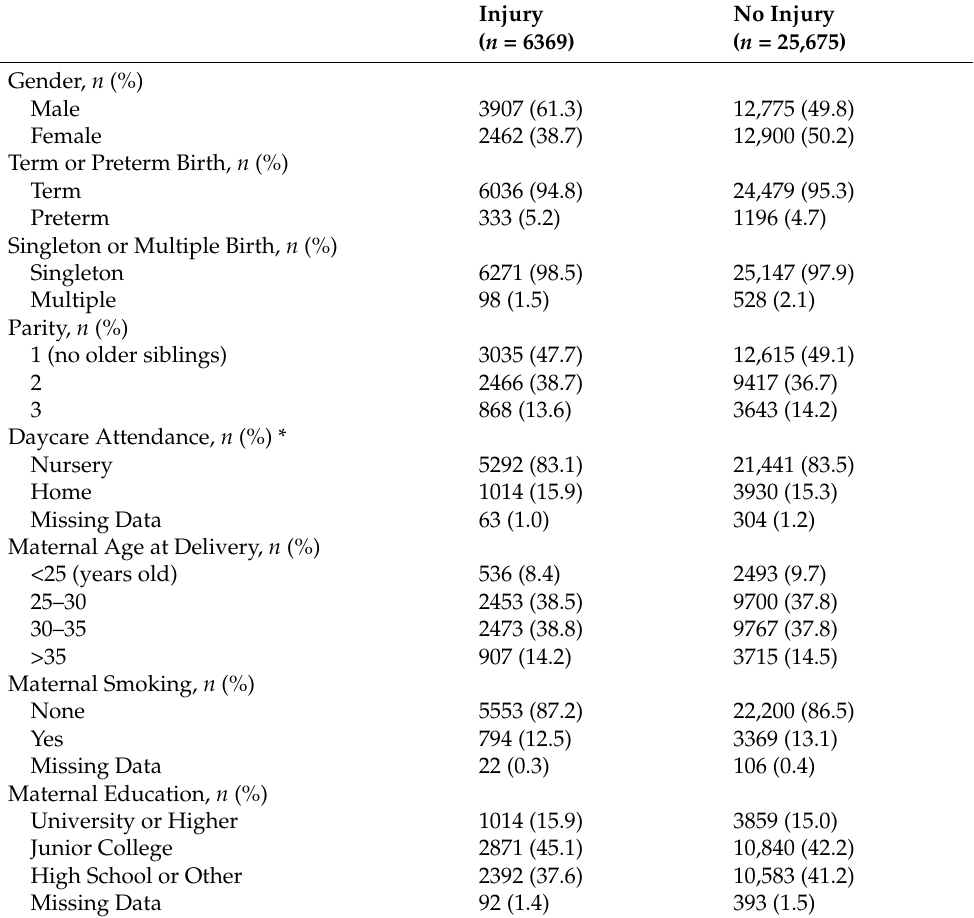
Table 2. Characteristics of children included in the analysis, with and without injuries ( n =